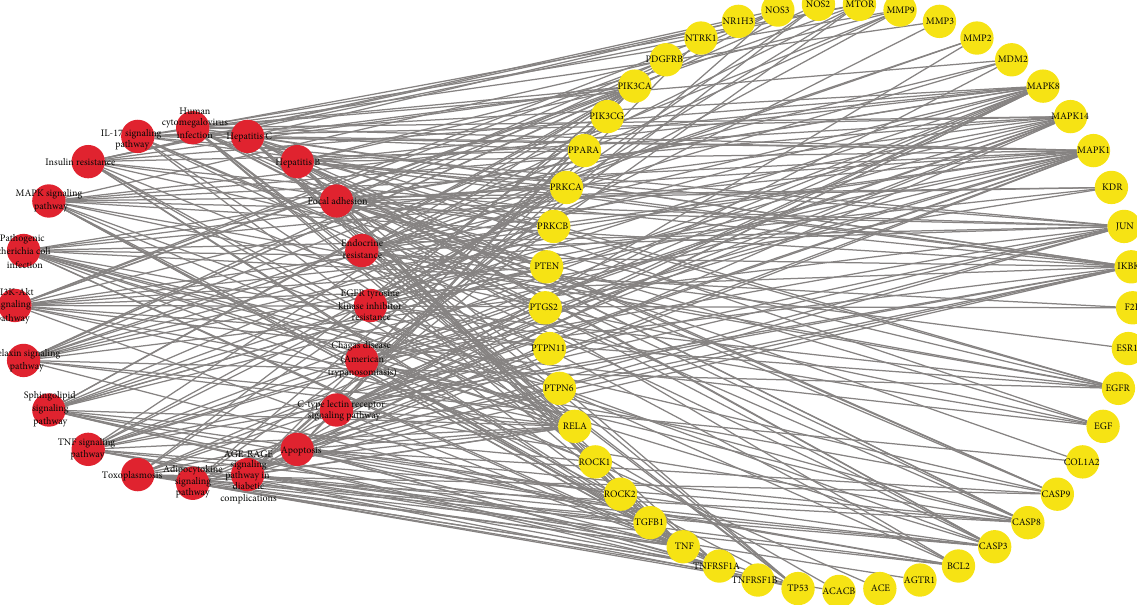
Figure 8: Pathway-target interaction network. Red circles indicate pathways which have interactions with potential targets, while the yellow circles represent putative